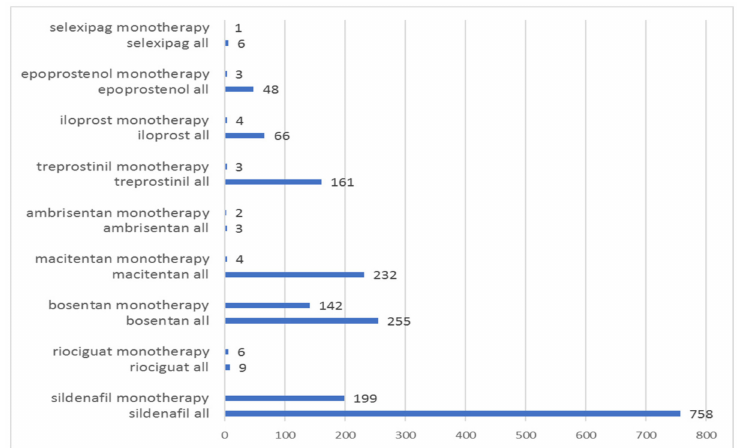
Figure A3. The use of pulmonary hypertension targeted therapies in registry patients. A total of 26 patients were participants in clinical trials at the time of enrollment, including 4 in randomized double-blind placebo-controlled trials and 23 in open-label extension